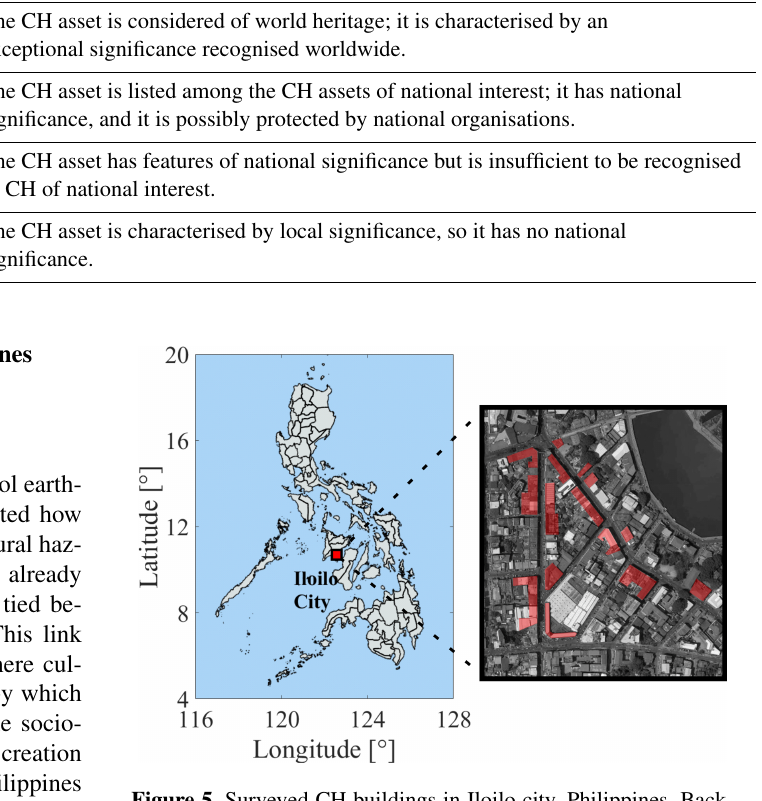
Figure 5. Surveyed CH buildings in Iloilo city, Philippines. Back- ground imagery by © 2019 CNES/Airbus, Maxar Technologies; map data by © 2019